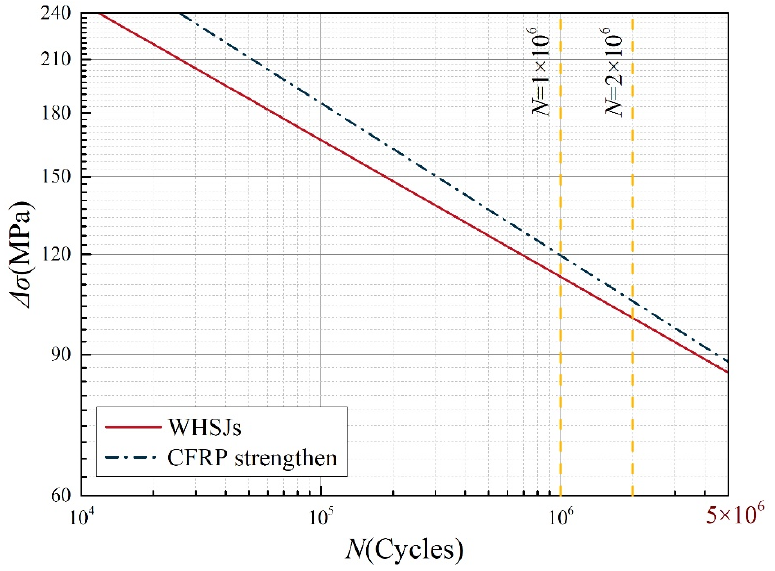
Figure 17. Summary of fitting curves.